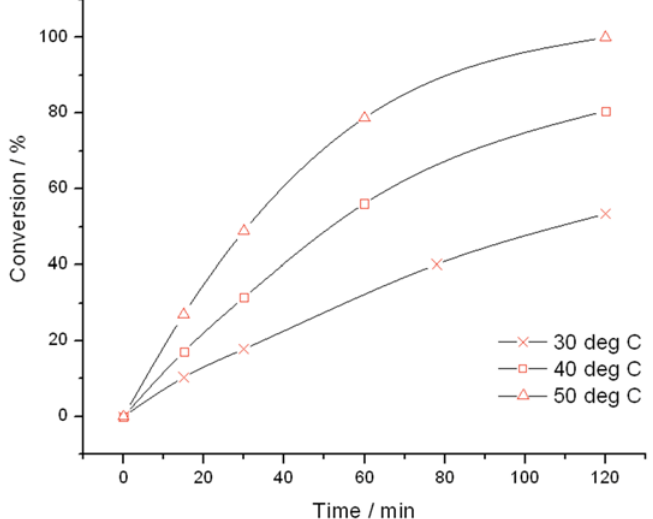
Figure 2. Time online analysis of allyl alcohol epoxidation with TS-1B. Reaction conditions: [allyl alcohol] = 0.5 M, [H 2 O 2 ] = 0.25 M, mass TS-1B = 50 mg, various temperatures. Conversion is calculated according to the initial concentration of H 2 O 2 (see experimental